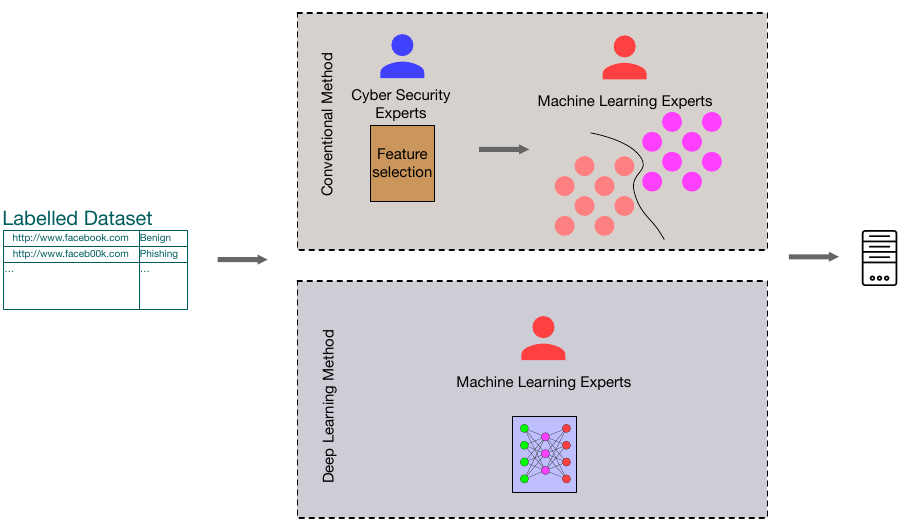
Figure 3. The phishing detection methods using classical machine learning methods and deep learning